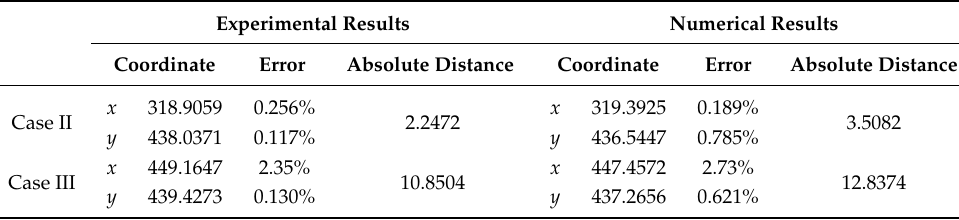
Table 5. Comparison of experiment and simulation results under Case II and Case III. Experimental Results